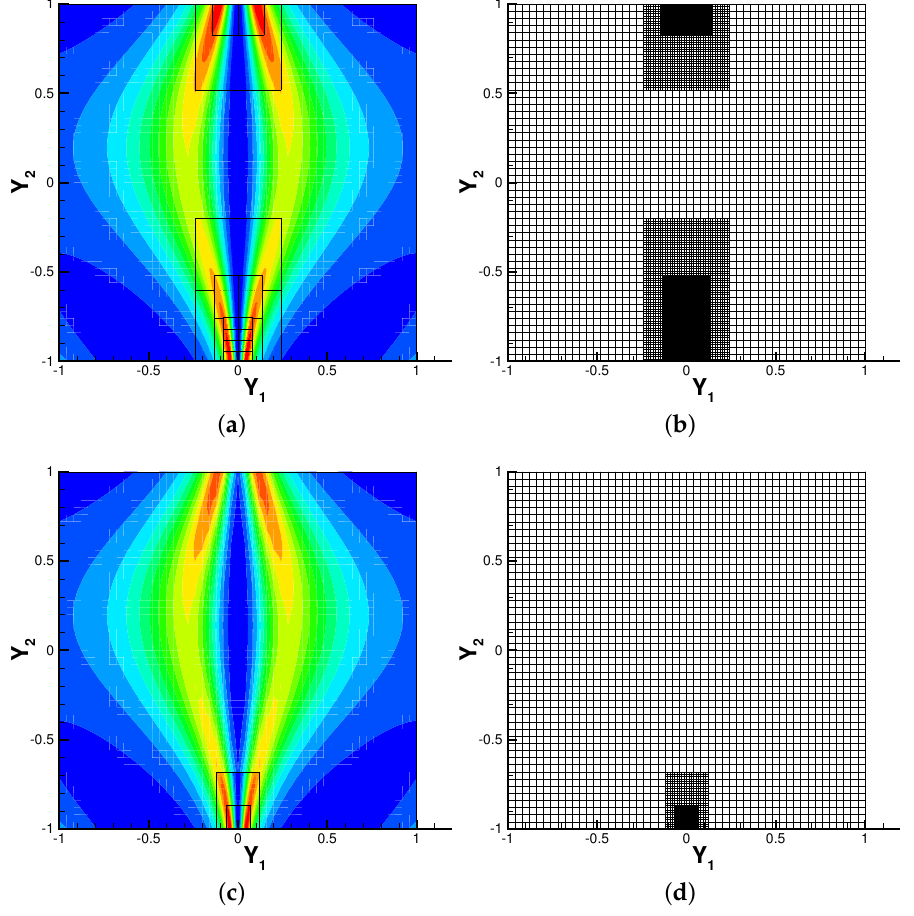
Figure 6. Contour plots of solution of the K-O problem in the random space. ( a ) y 1 with (cid:101) = 2; ( b ) AMR mesh with (cid:101) = 2; ( c ) y 1 with (cid:101) = 2; ( d ) AMR mesh with (cid:101) = 10.